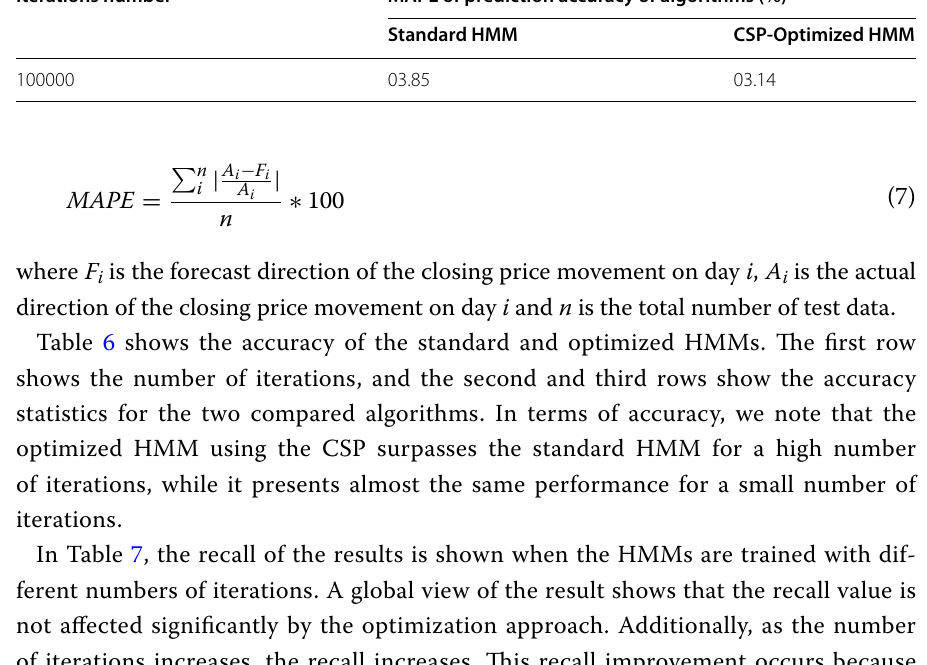
Table 10 Mean absolute percentage error (MAPE) of prediction accuracy comparison Iterations number MAPE of prediction accuracy of algorithms